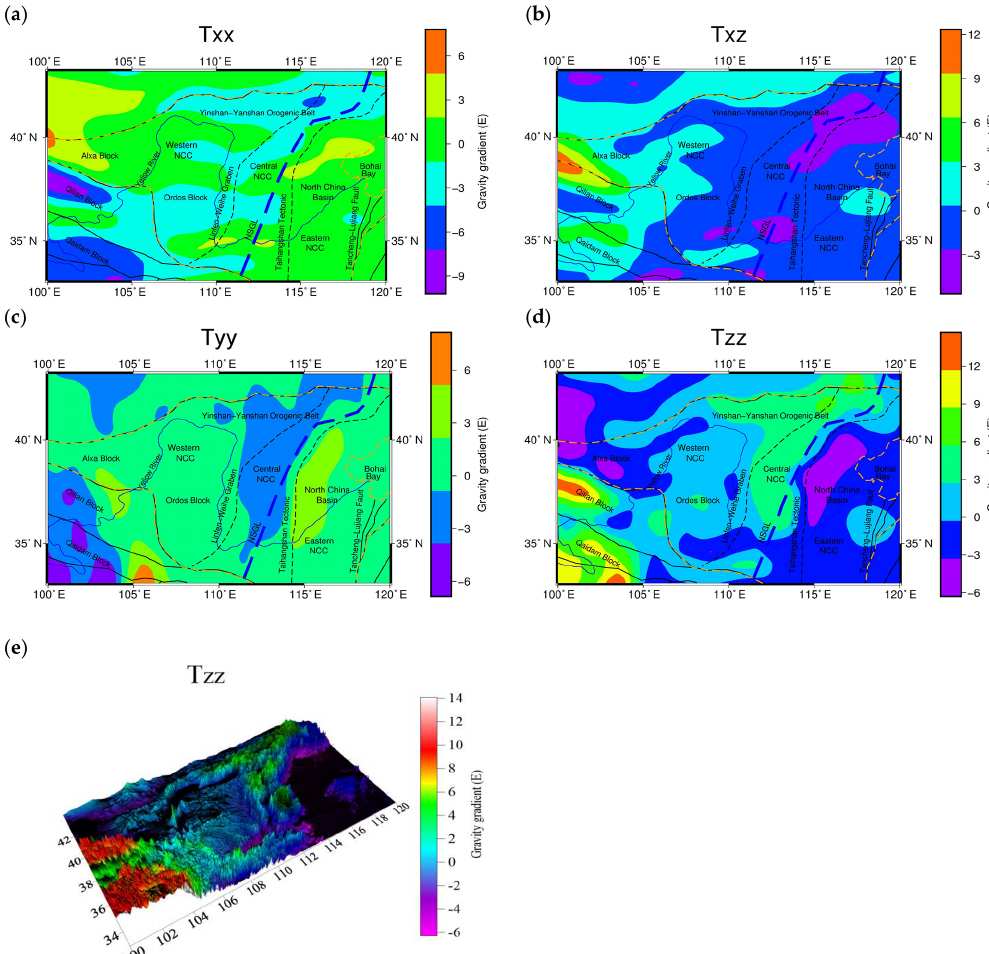
Figure 9. Gravity gradient effect caused by topographic masses: (a) T xx , (b) T xz , (c) T yy , (d) T zz and (e) the 3D gravity gradient effect T zz of